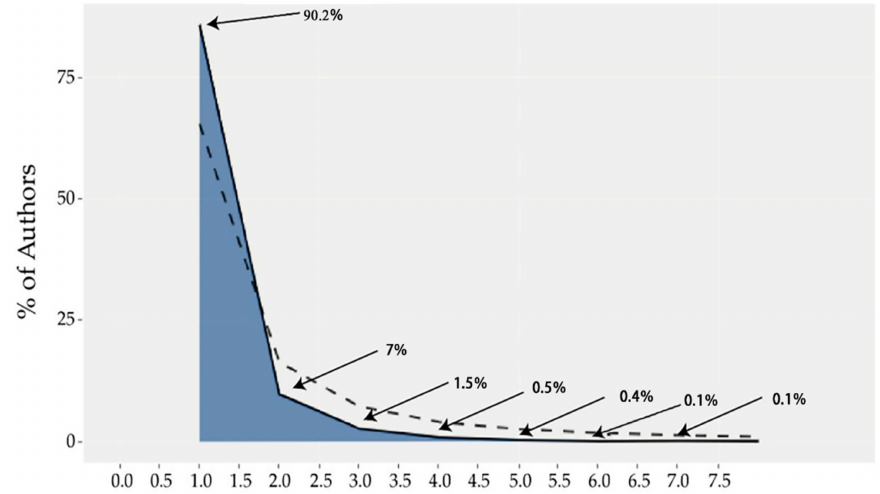
Figure 4. Frequency distribution of scientific productivity in land use